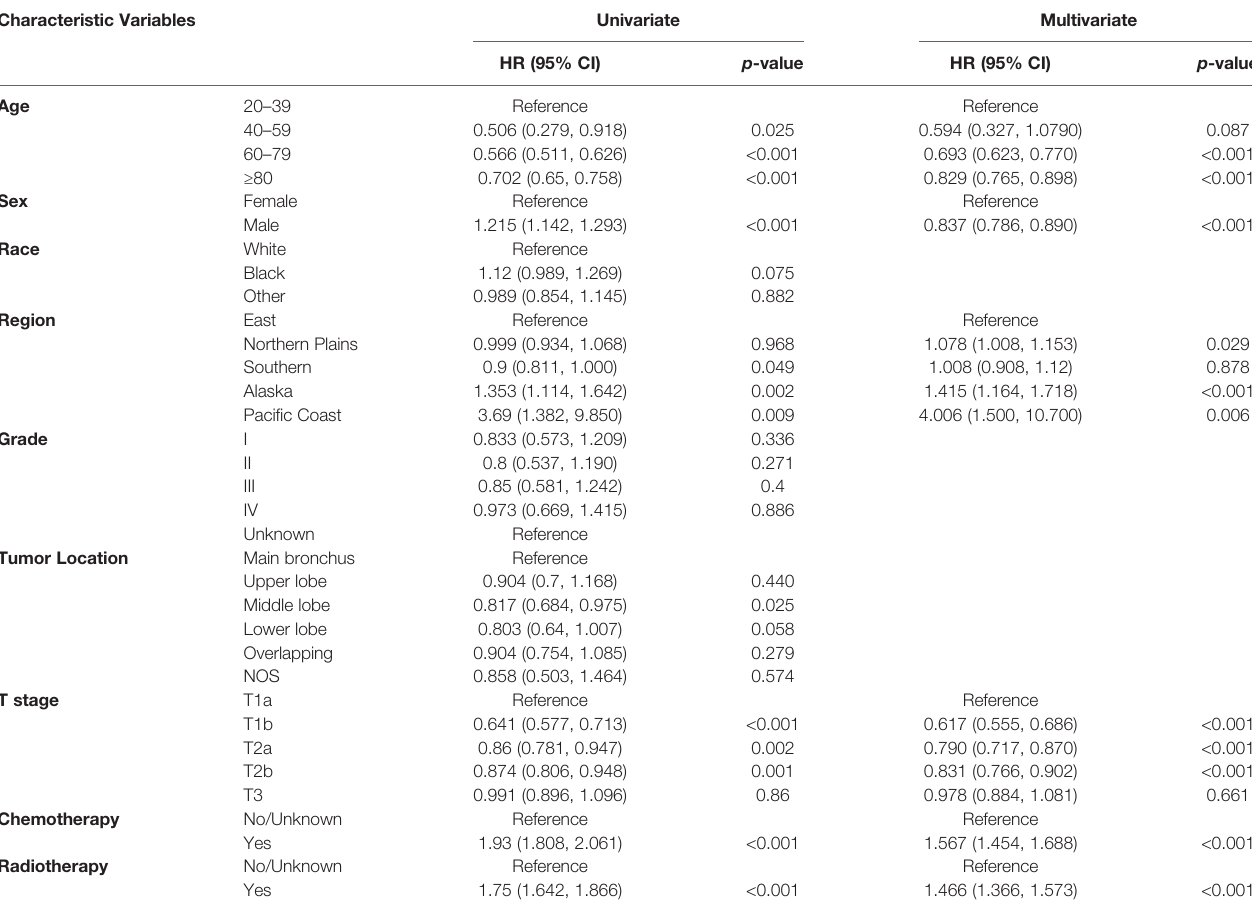
TABLE 1 | Univariate and multivariate analyses for OS in patients with unresectable IIIA-N2 LUAD. Characteristic